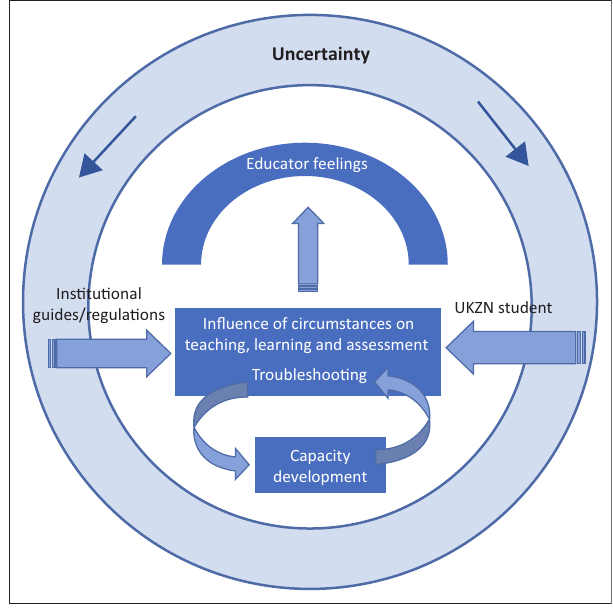
FIGURE 2: Themes dominant in the